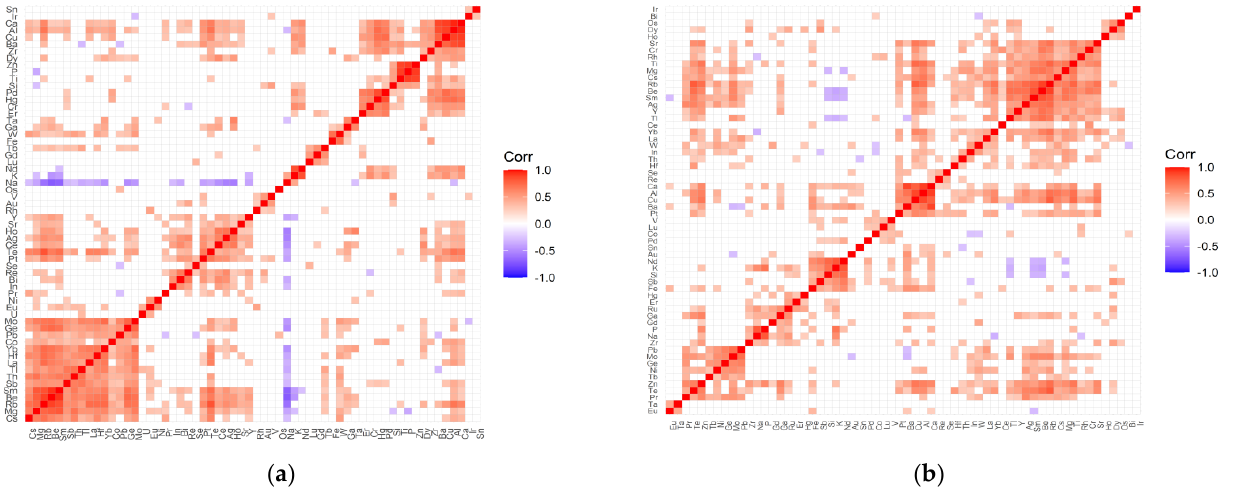
Figure 3. Correlation matrix for the control ( a ) and test ( b ) groups representing patients with cataract and coexisting hy- pertension.